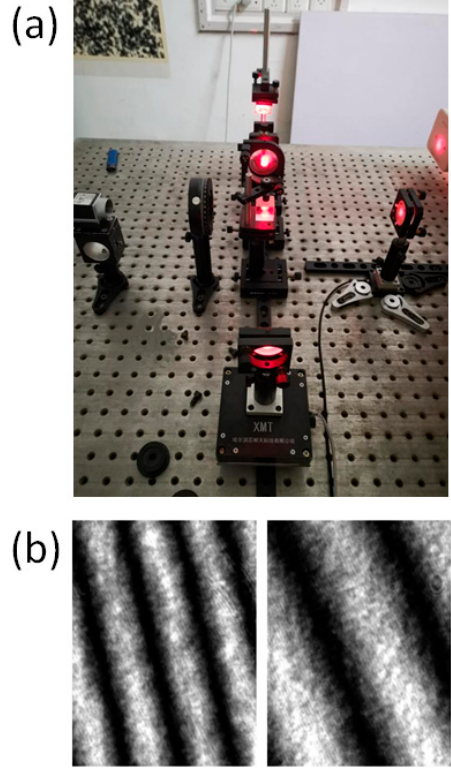
Figure 10. ( a ) Physical diagram. ( b )